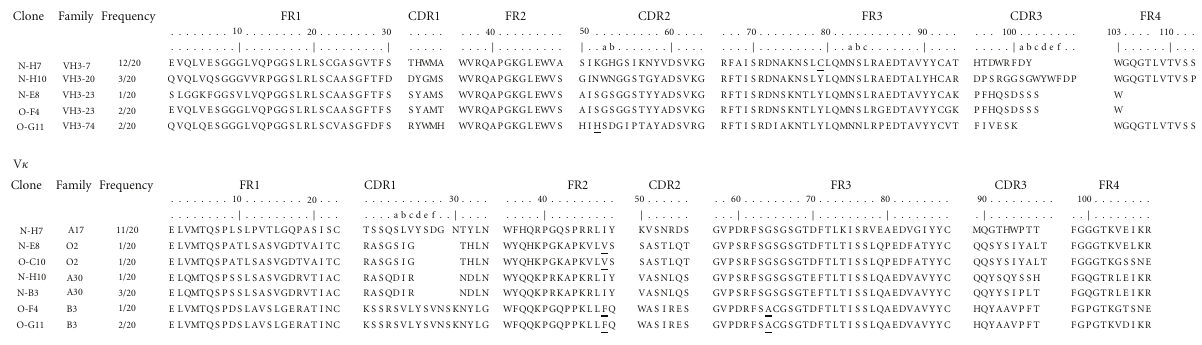
Figure 2: Variable gene repertoires of selected Fabs. Twenty di ff erent reactive Fab genes were sequenced, and the amino acid sequences of their VH (upper panel) and V κ (lower panel) domains were deduced. Framework (FR) and complementary determining regions (CDR) are shown. The unusual residues are